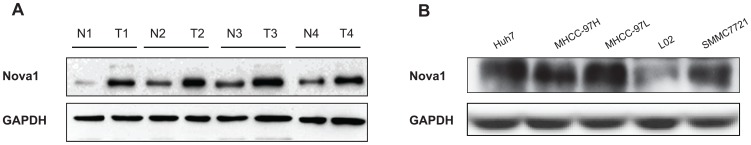
Nova1 expression in HCC tissues, as well as four HCC and one normal liver cell lines.(A) Nova1 expression in four pairs of HCC (T) and paired nontumor tissues (N) of the liver. (B) Nova1 expression in indicated HCC (including MHCC-97H, MHCC-97L, Huh7 and SMMC-7721 cell lines) and one normal liver cell lines.